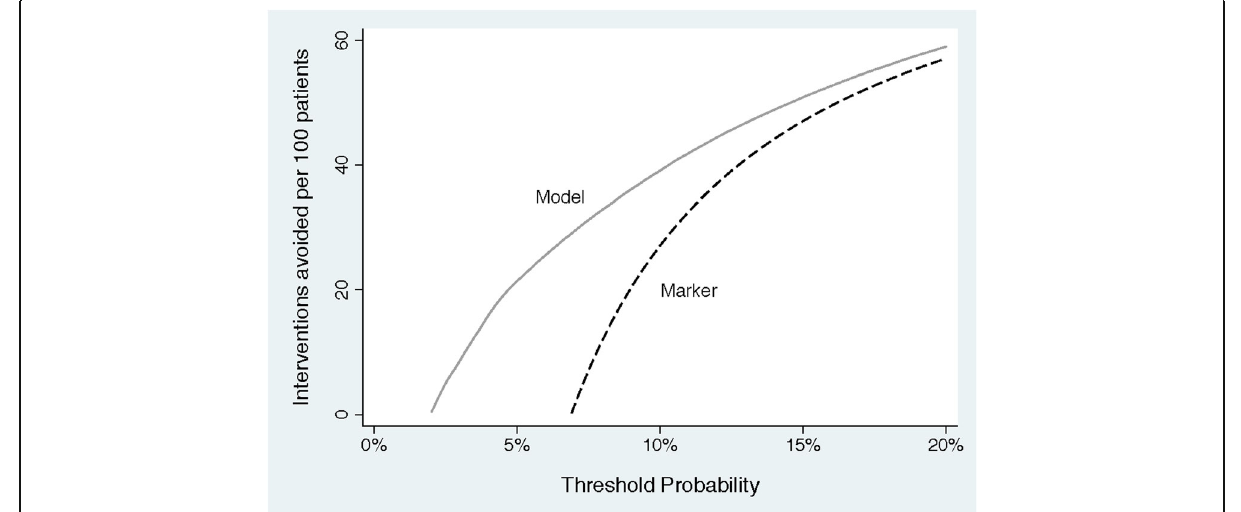
Fig. 3 A decision curve plotting decrease in interventions against threshold